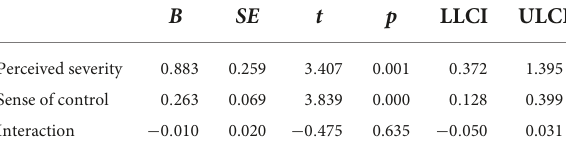
TABLE 3 Moderation effect of sense of control on the relationship between perceived susceptibility and adherence.